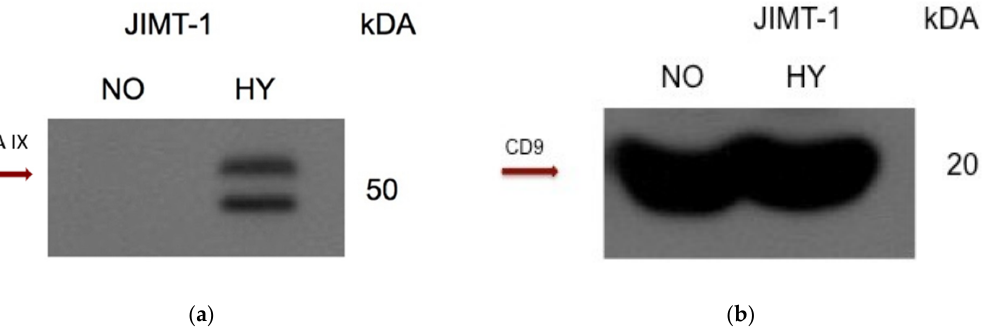
Figure A3. Characterization of exosomes isolated from hypoxic JIMT-1 cells. ( a ) The size distribution was analyzed by NTA using NanoSight NS500 (for each sample 5x 60-second run); ( b ) representa- tive nanoparticle tracking analysis (NTA) of isolated exosomes diluted with DPBS. The expression of CA IX in exosomes isolated from JIMT-1 cells was also determined using Western blotting. Figure A4a shows the level of CA IX in exosomes detected in hy- poxia. The correct isolation of exosomes was verified through the presence of a specific marker of exosomes—CD9 (Figure A4b). Figure A4. Characterization of exosomes from JIMT cells grown in hypoxia for 48 h. Expression of CA IX ( a ) and CD9 (specific marker of exosomes) ( b ) proteins was analyzed by Western blotting using specific antibodies.